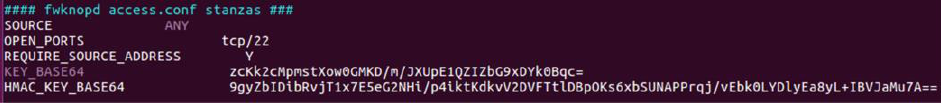
Figure 10. FWKNOP configuration information.